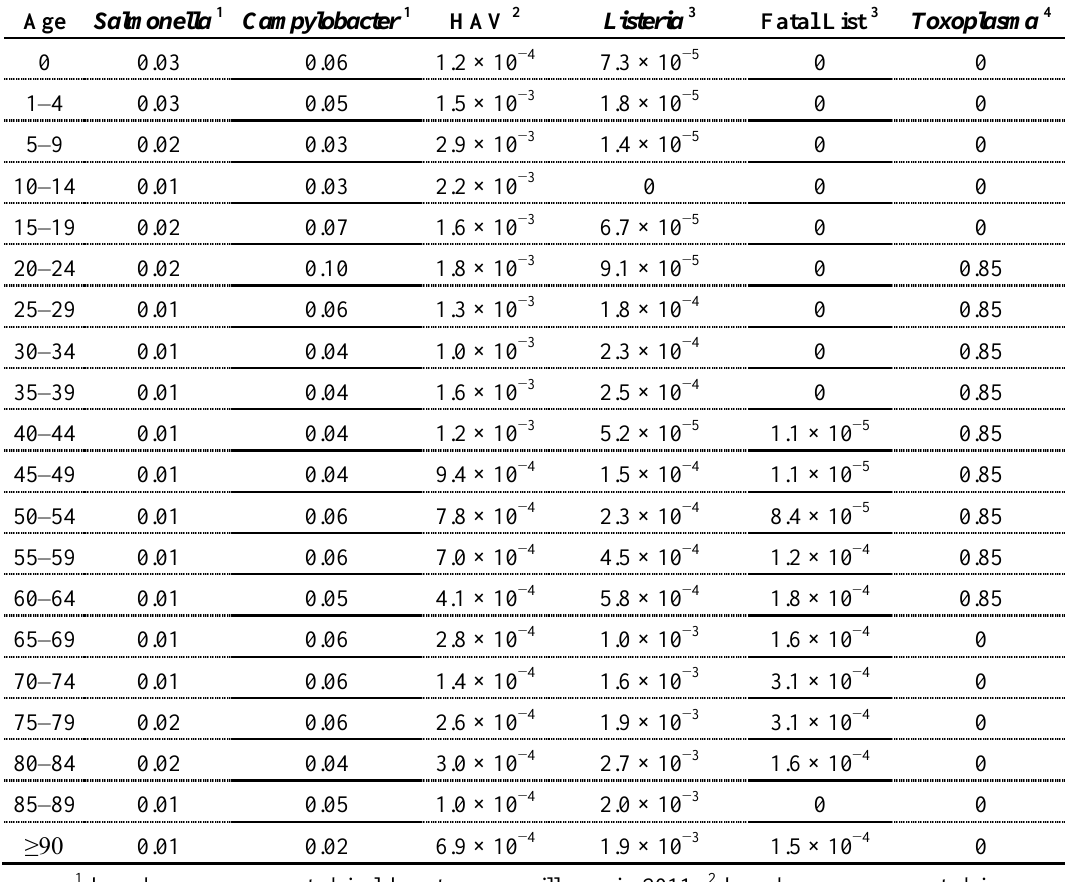
Table 1. Estimated age-specific risks (%) for five important foodborne pathogens in The